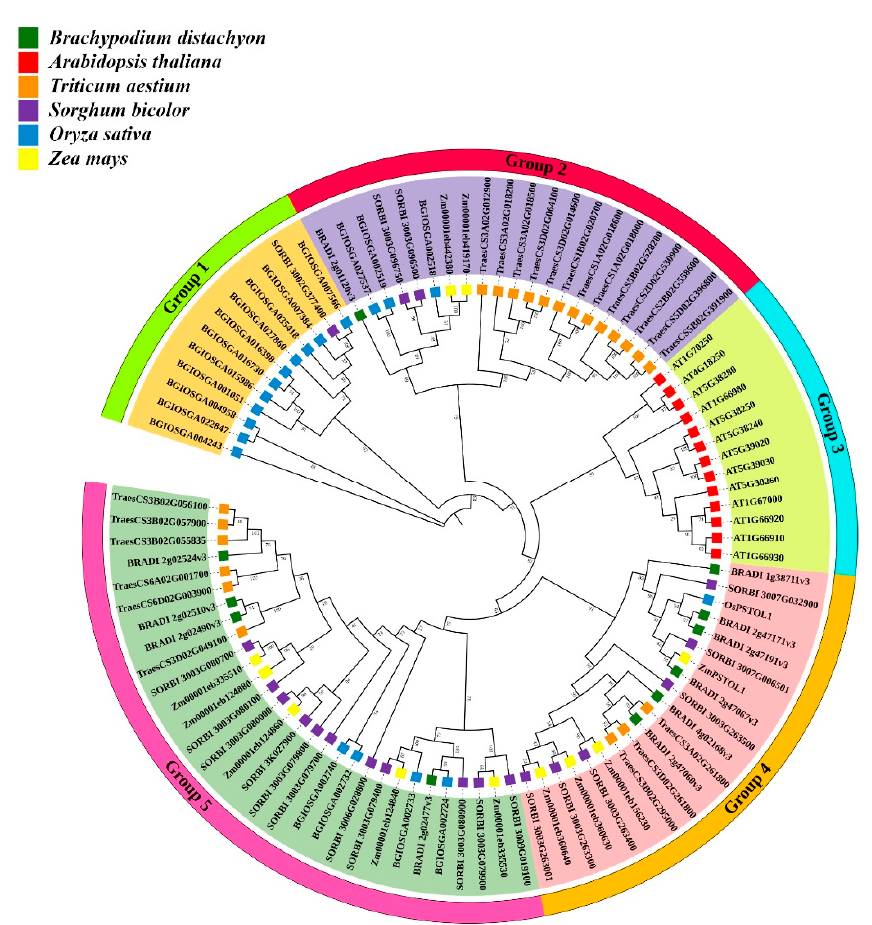
Figure 2. PSTOL1 wheat orthologs in Triticum aestivum L., Arabidopsis thaliana , Sorghum bicolor , Zea mays , and Oryza sativa . A total of 96 homologs were aligned in ClustalW, and a phylogenetic tree was constructed in MEGAX using the NJ method. The percentage of replication is presented next to the branches. Homologs from different species are shown with variable-colored squares, such as green color for Brachypodium distachyon , red for Arabidopsis thaliana , brown for Triticum aestivum L., purple for Sorghum bicolor , blue for Oryza sativa, and yellow for Zea mays